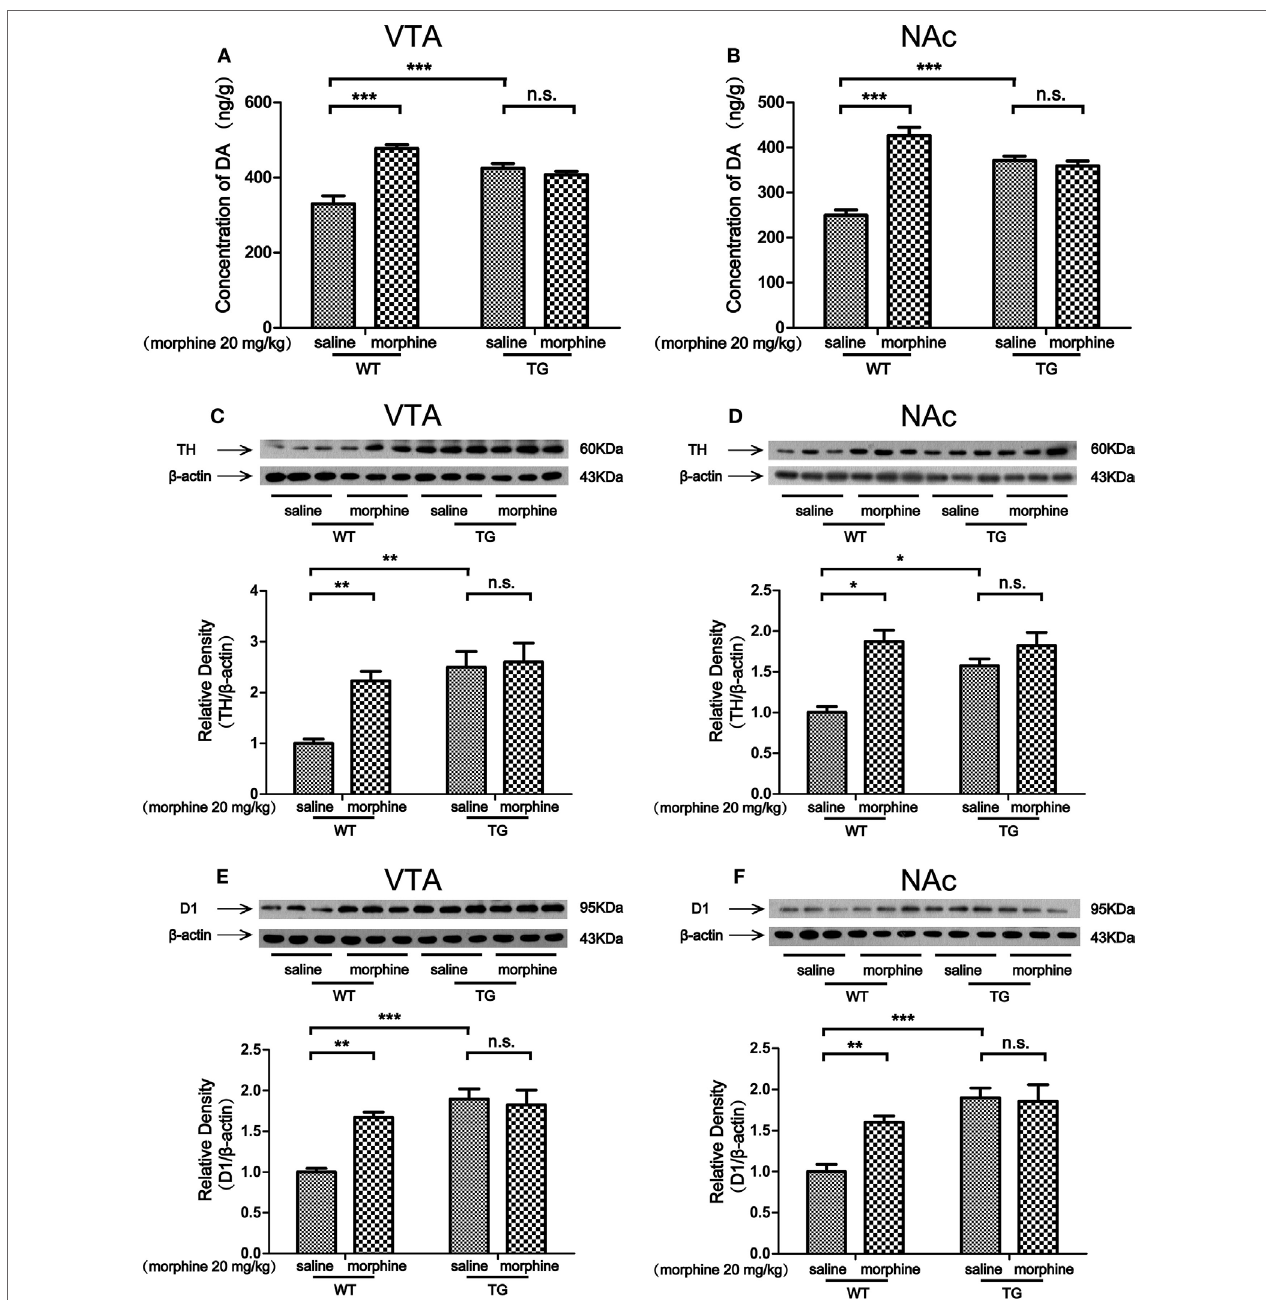
FigUre 4 | Dopamine (DA) concentration and the expressions of tyrosine hydroxylase (TH) and D1 in the ventral tegmental area (VTA) and nucleus accumbens (NAc). Immediately following the post-conditioning test, the VTA and NAc of mice were dissected out. DA concentration was detected by high performance liquid chromatography in the VTA (a) and NAc (B) . The expressions of TH and D1 were detected by western blot analysis. Thioredoxin-1 (Trx-1) overexpression inhibited the further increase of TH induced by morphine in the VTA (c) and NAc (D) . Trx-1 overexpression inhibited the further increase of D1 induced by morphine in the VTA (e) and NAc (F) . Each bar represents the mean ± SE ( n = 6). n.s. > 0.05, * P < 0.05, ** P < 0.01, and *** P < 0.001, statistically significant.